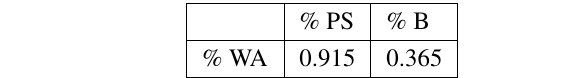
Table 5. Correlation table for WA of Bagasse based bricks